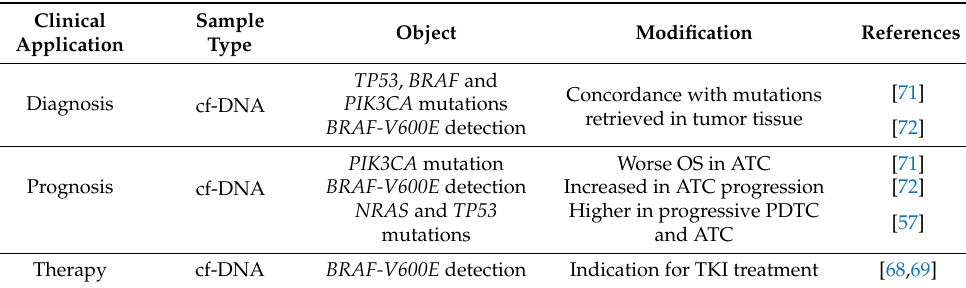
Table 2. Potential implications of liquid biopsy for the diagnosis, prognostic definition, and therapy of poorly differentiated/anaplastic thyroid